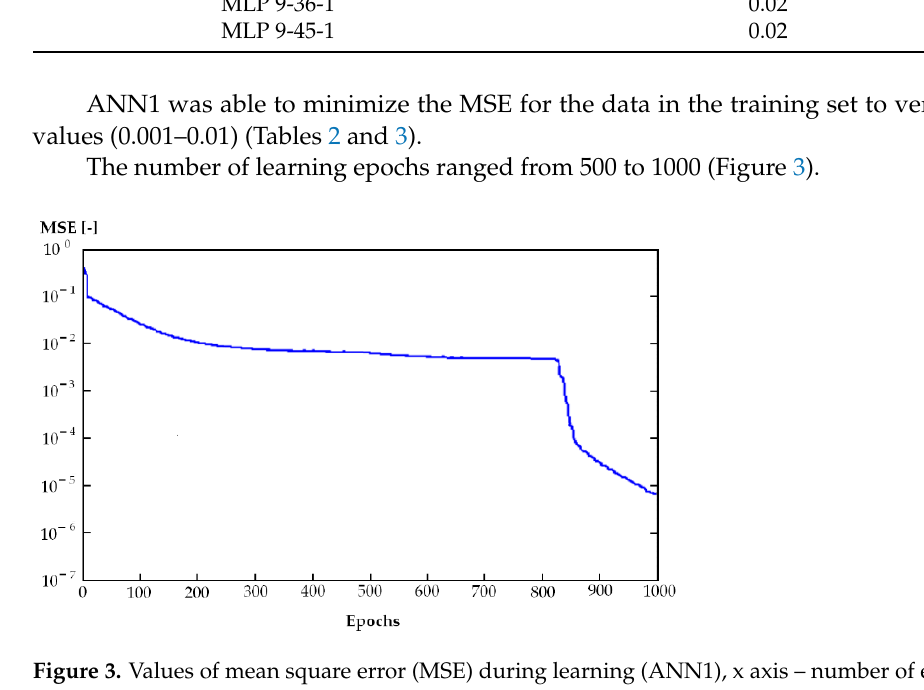
Table 3. (R - root) MSE (Mean squared error) values for three-MLP (MultiLayer Perceptron) neural networks (bolded is the best).